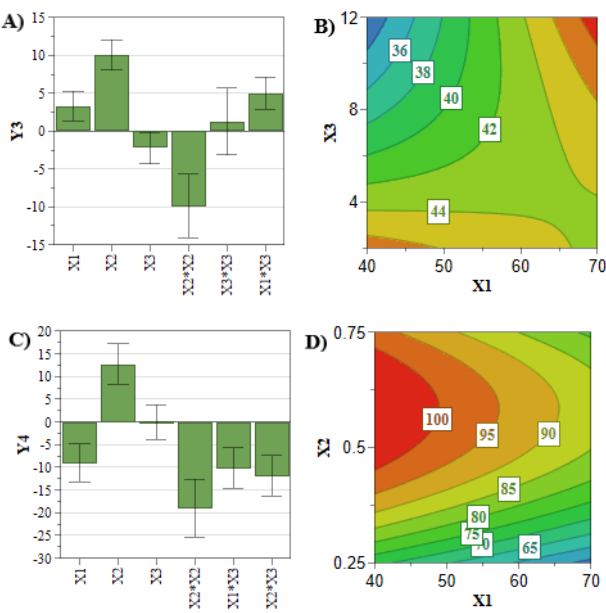
Figure 4. Coefficient plots for SIM ( A ) and DOX ( C ) EE%. Response contour plots for SIM ( B ) and